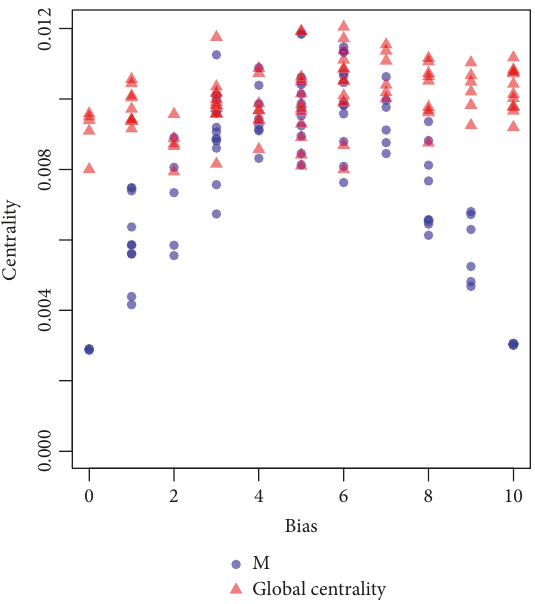
Figure 3: Individuals’ centrality values and bias in Simulation 1. The centrality value of an individual is computed using two methods (mediation centrality and global centrality) and shown on the y-axis asa functionof theindividual’s bias. Bias is shownhereas theinteger number of reasons on the pro side (i.e., 10𝛽